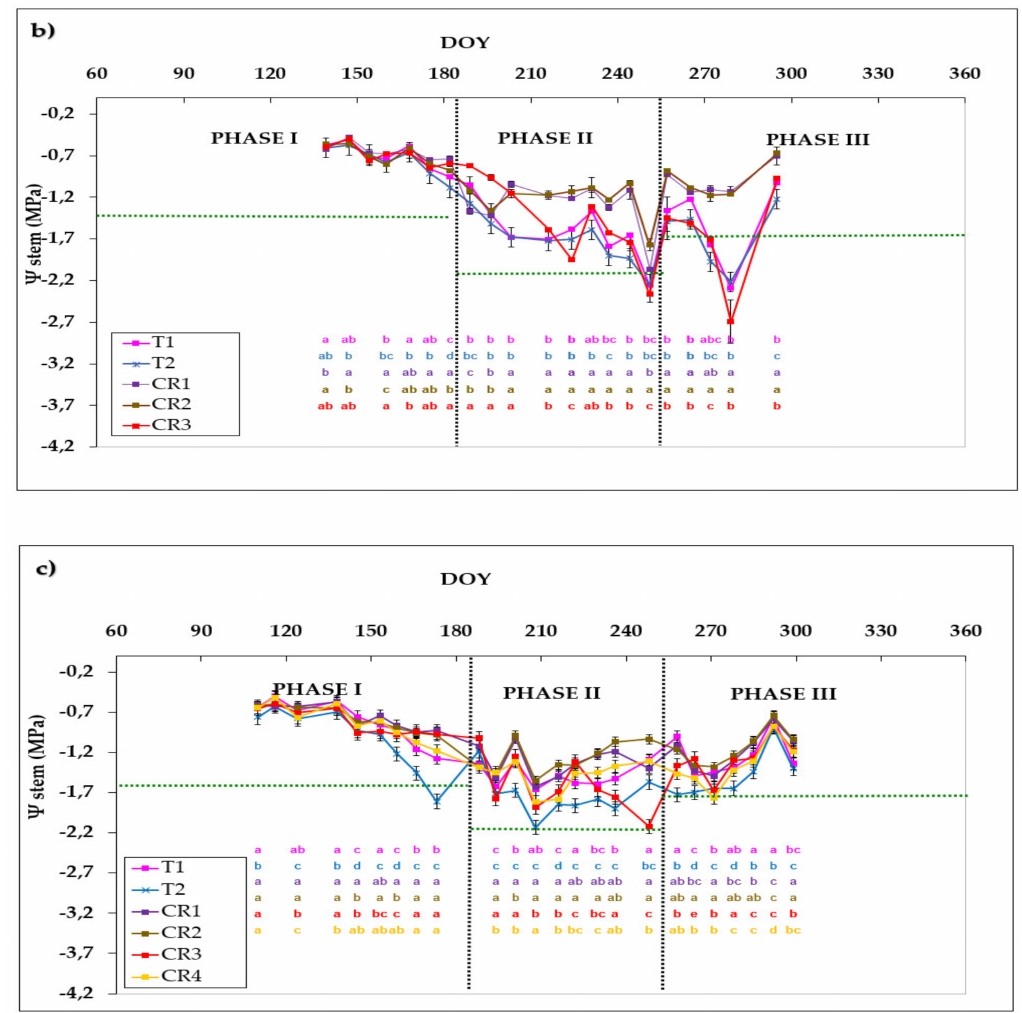
Figure 7. Seasonal patterns of midday stem water potential ( Ψ stem ) during the 2015 ( a ), 2016 ( b ) and 2017 ( c ) seasons in representative trees at each control point. Each value is the mean of four measurements ± standard error. The vertical dashed line indicates the moment at which each phase ends. The horizontal dashed line indicates the threshold established for each crop phase. Di ff erent letters in the same column indicate statistically significant di ff erences according to Duncan’s multiple range test ( p < 0.05). Letters are not shown when no di ff erences were found. DOY is the day of the